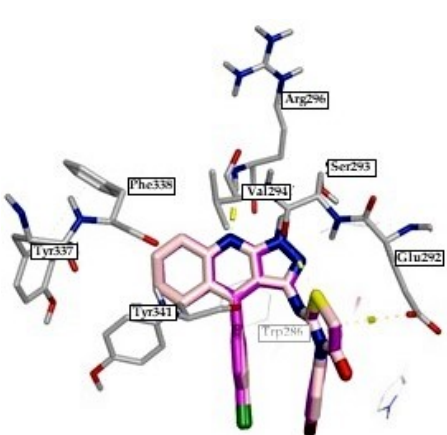
Figure 6. Molecular modeling of 27a (rose) and 27b (purple) with h AChE showing the interaction with the PAS (adapted from [86], with permission from Elsevier). Key interactions noted are the tricyclic core showing favorable hydrophobic interactions with Tyr341, Tyr337, Phe338, and Val294, the4-chlorophenylsubstituentshowinghydrophobicinteractionswithTyr341andTrp286, thequinolinyl nitrogen showing an H-bond with Arg296, and the thiazolidinone moiety showing favorable interactions with Glu292 and